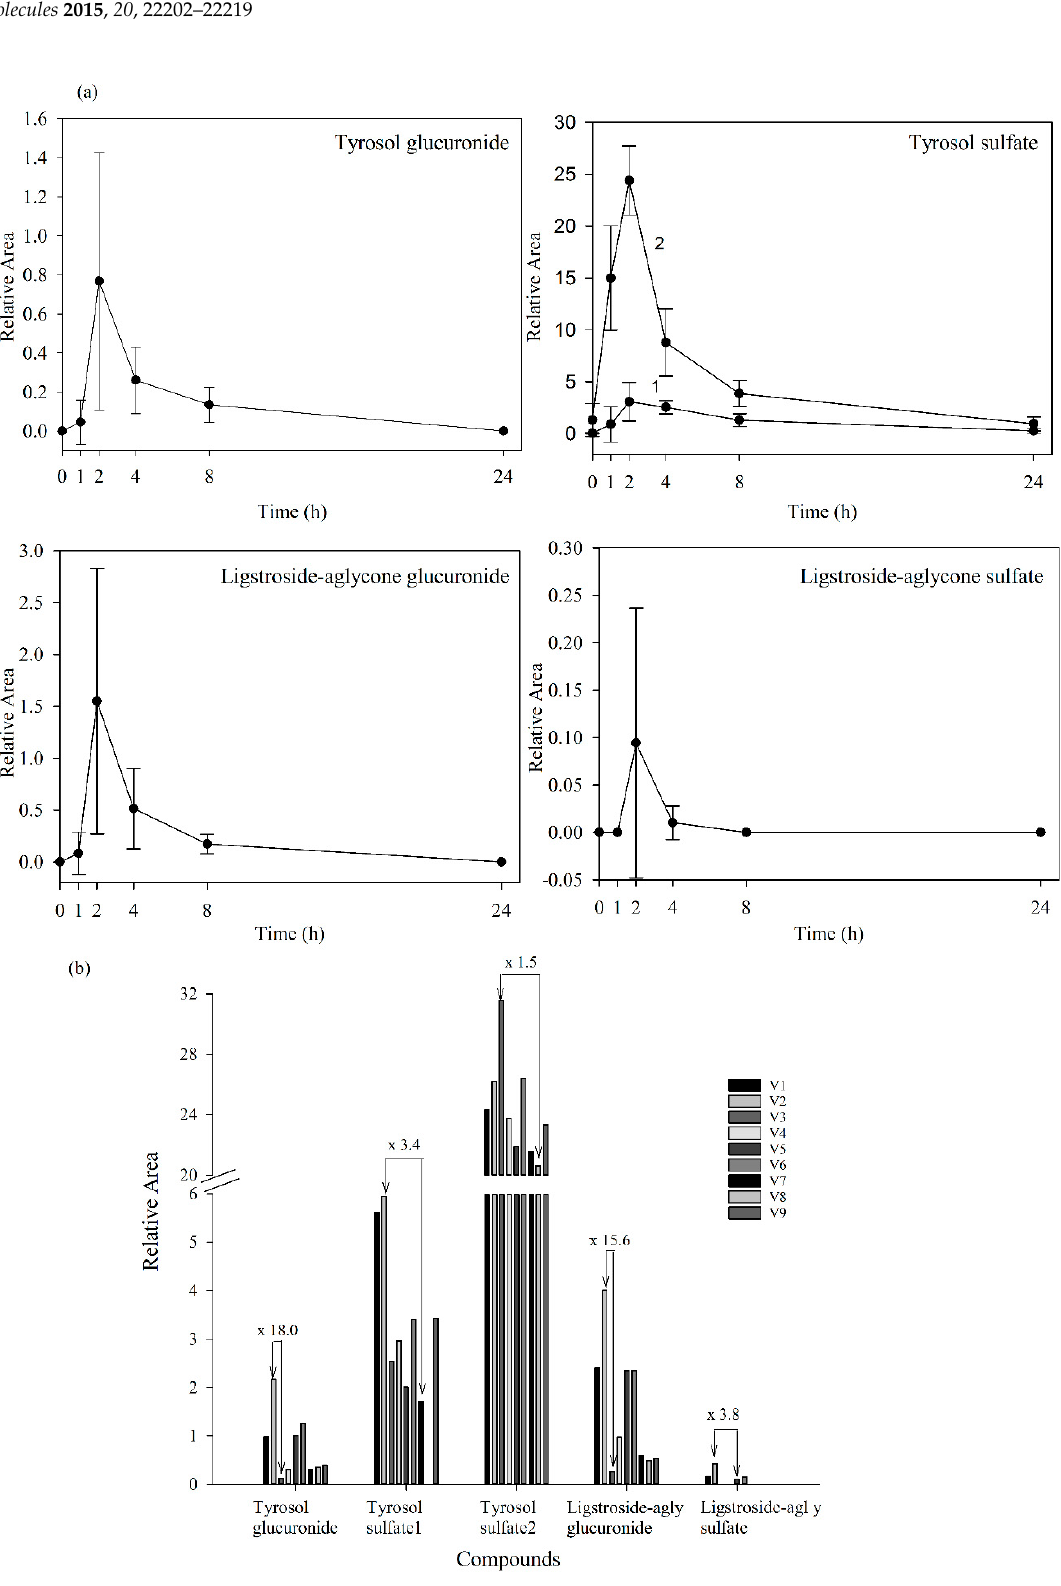
Figure 4. ( a ) Plasma levels-time courses of the targeted metabolites detected. Values are means of nine volunteers with SD shown by vertical bars (1 and 2 correspond to two isomers of tyrosol sulfate); ( b ) Inter-individual variability in the content of the targeted metabolites observed in plasma 2 h after the consumption of the Fraxinus angustifolia Vahl extract. Differences between maximum and minimum values are indicated. All results are shown as relative peak areas (relative area = (peak area metabolite × 100/peak area internal standard)).